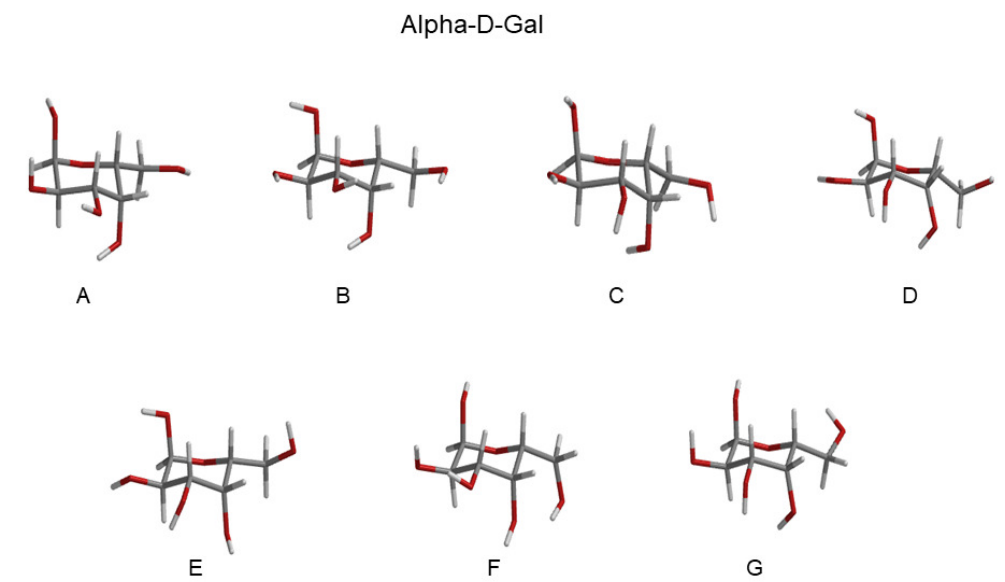
Figure 13. Schematic view of the Alpha-Gal RCs extracted from the basins, as reported in Figure 12. Additional details can be found in the Supplementary